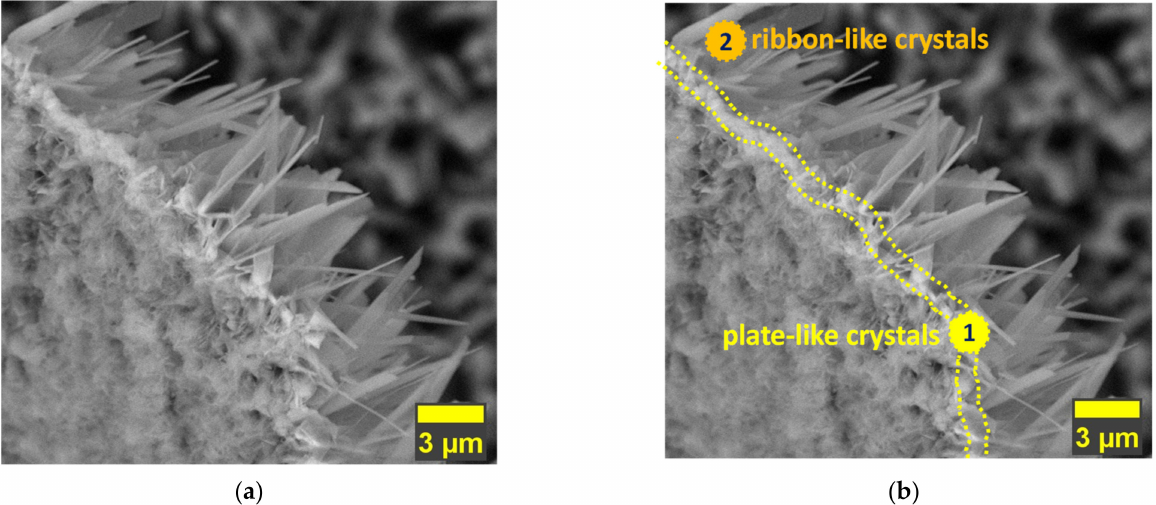
Figure 3. Representative SEM images of the Mg-doped HAp coatings (H/Mg2) in section without ( a ) and with ( b ) annotations (see Figure S3 in supplementary file for the original SEM